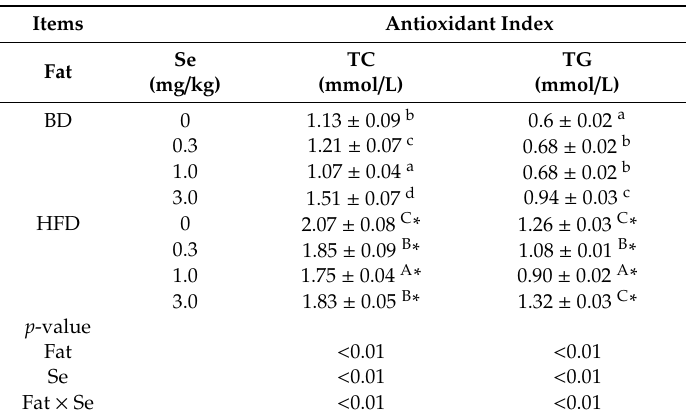
Table 6. Results of the concentrations of TC and